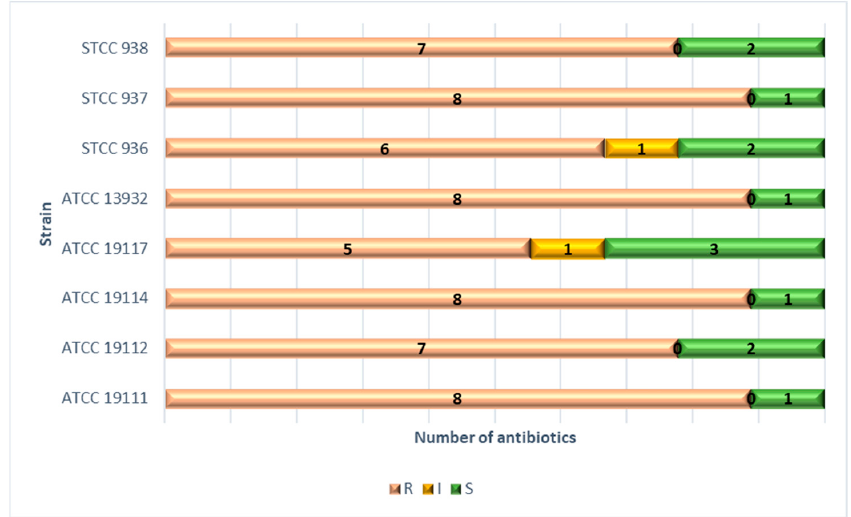
Figure 2. Number of antibiotics to which each strain of L. monocytogenes was resistant, intermediate (with reduced susceptibility), or susceptible. ATCC—American Type Culture Collection; STCC—Spanish Type Culture Collection.